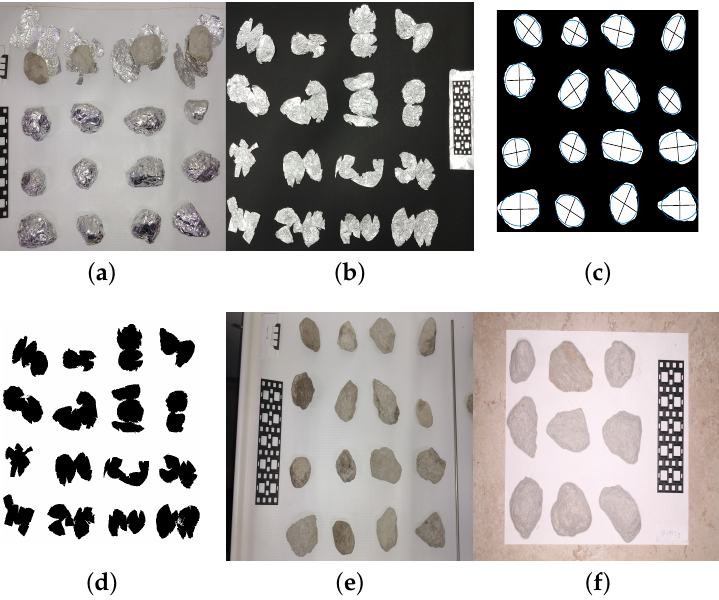
Figure A3. Sample of photographies and images used in the surface area compute process for the pumice stones. ( a ) Pumice stones of 3.5 to 4.5 mm cover with aluminium foil. ( b ) Photography of aluminium foil layers. ( c ) Ellipse approximation of each pumice stone for 34.9–45.0 mm size. ( d ) Binarized image of the aluminium foil layers. ( e ) Sample of photography for pumice stones of 34.9–45.0 mm size and template. ( f ) Sample of photography for pumice stones of 45.0–55.0 mm size and